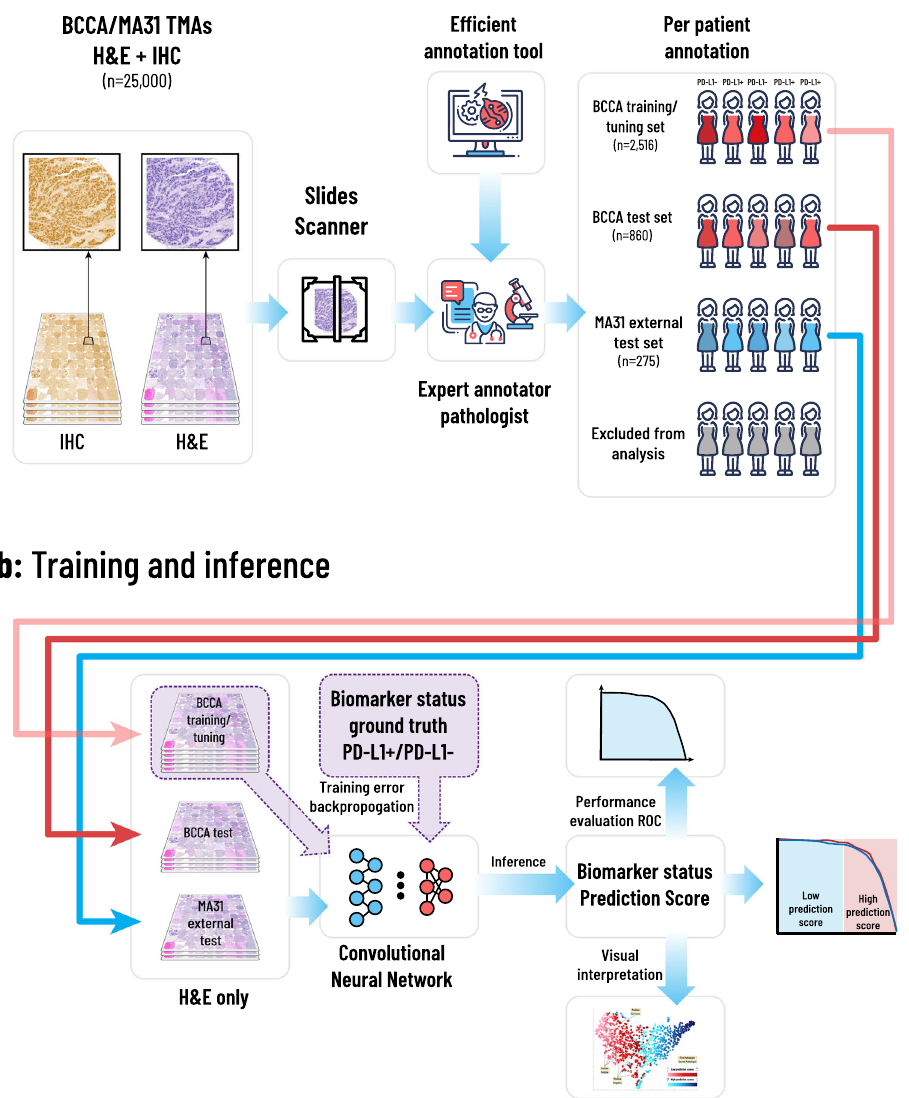
Fig. 1 | Overview of the proposed framework. The annotation, training, and inference methodologies. a An expert pathologist used our designed computer- aidedannotationsoftwaretoannotatepatientsforPD-L1status,basedontheirH&E and corresponding IHC-stained TMA images. Patients with no TMAs, unclear ima- ges, de fi cient staining, and with insuf fi cient tissue or tumor, were excluded from theanalysis.TherestofthepatientswereassignedeachaPD-L1positiveornegative label,resultingin2516annotatedpatientsintheBCCAtrainingset,860intheBCCA testset,and275intheMA31externaltestset. b H&Eimagesoftheincludedpatients